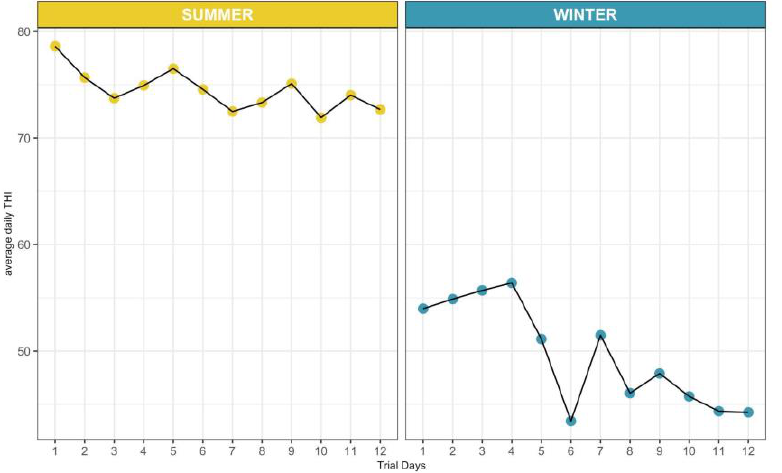
Figure 1. Variation of the average temperature and humidity index in the 12 summer and winter trial days.